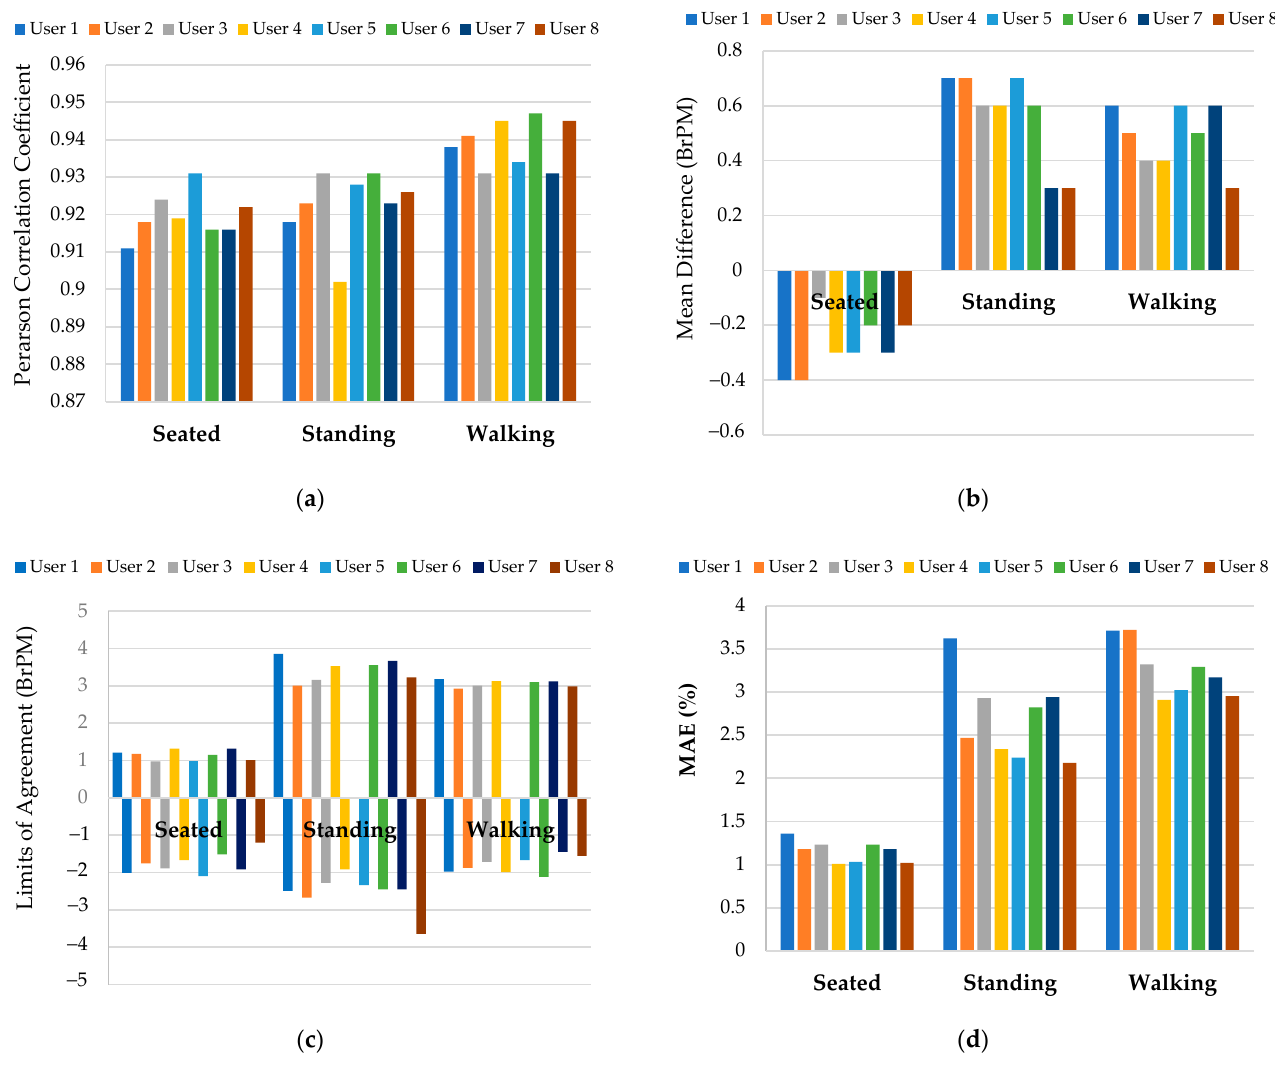
Figure 13. Histograms reporting on the results of the chest band characterization over eight users under different operating conditions (i.e., seated, standing, and walking); Pearson correlation coefficient ( a ), mean difference ( b ), limits of agreement ( c ), and percentage mean absolute error ( d ).